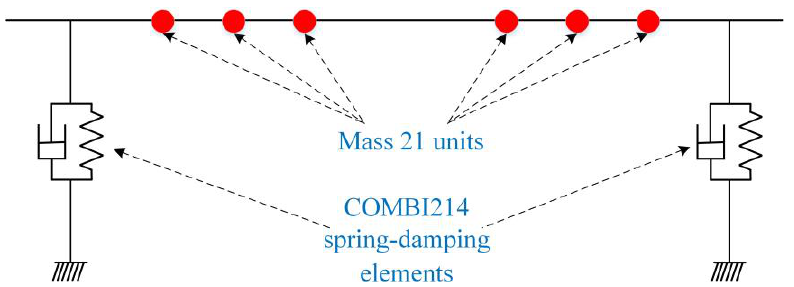
Figure 3. Description of the equivalent dynamic model for a multi-stage centrifugal pump rotor system.